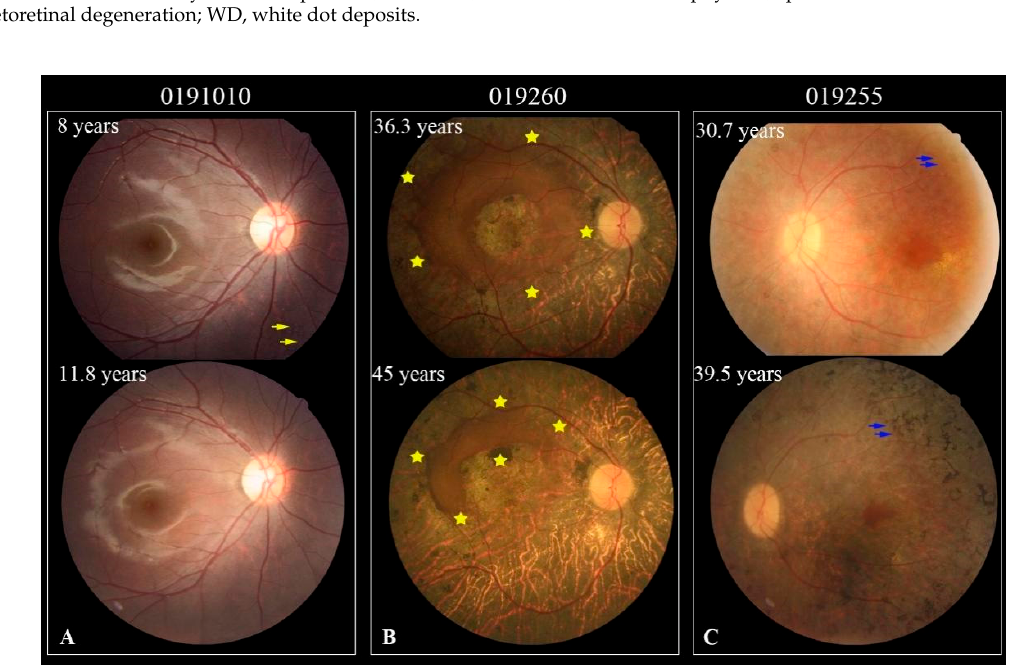
Table 2. The follow-up information and clinical features of patients with biallelic RPE65 variants in this study. Age ( Year ) Patient ID Gender